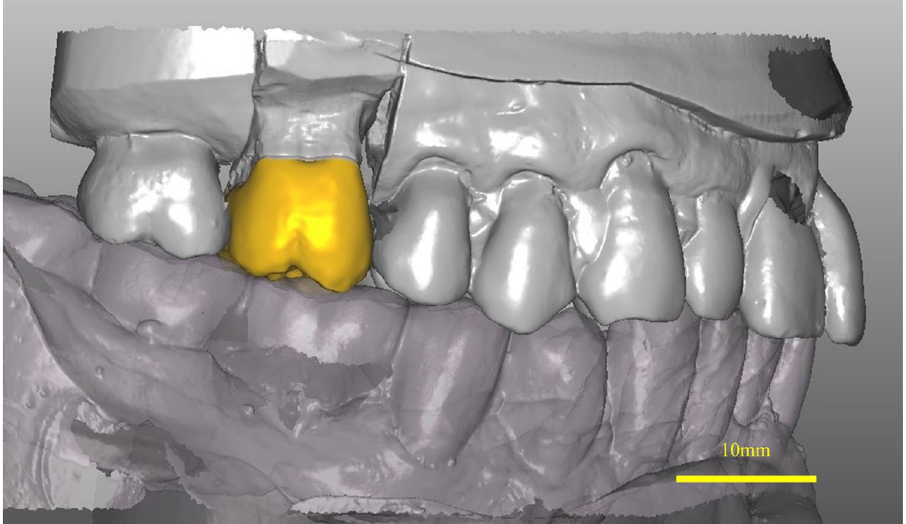
Figure 1. Computer-aided design of polyetheretherketone crown. *CAD design of a PEEK crown on an upper right first molar to harmonize the occlusal contact with the antagonists and the contact relationship with the adjacent teeth.